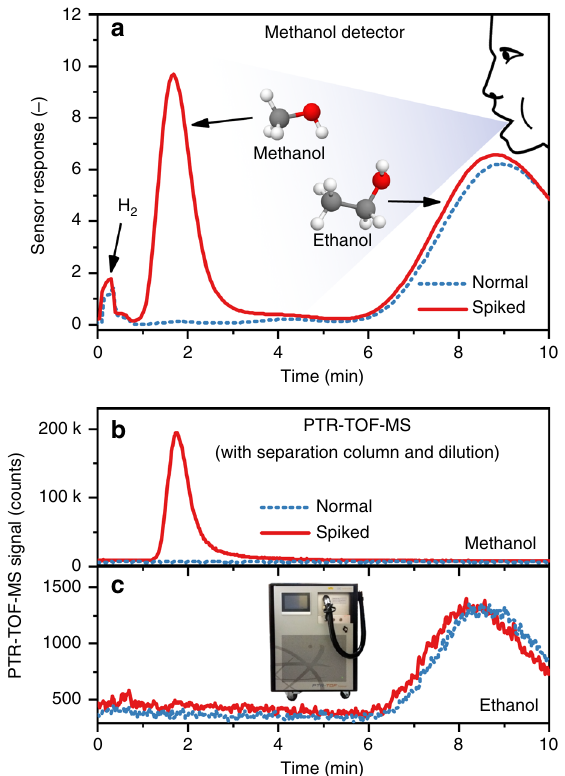
Fig. 6 Methanol detection in spiked breath. a Response of the methanol detector to breath of an intoxicated volunteer (0.54 ‰ blood alcohol level) sampled from Tedlar bags. The blue dashed line shows the measurement from the normal breath sample and the red solid line from the spiked sample with 135 ppm methanol, indicating methanol intoxication. The PTR- TOF-MS measurements (with separation column and dilution) of the same samples for b methanol and c ethanol. The instrument shown in c is a PTR- TOF-MS 1000 (Ionicon, Austria) used for sensor validation. Hydrogen (H 2 ) is not retained by the separation column and does not interfere with the methanol